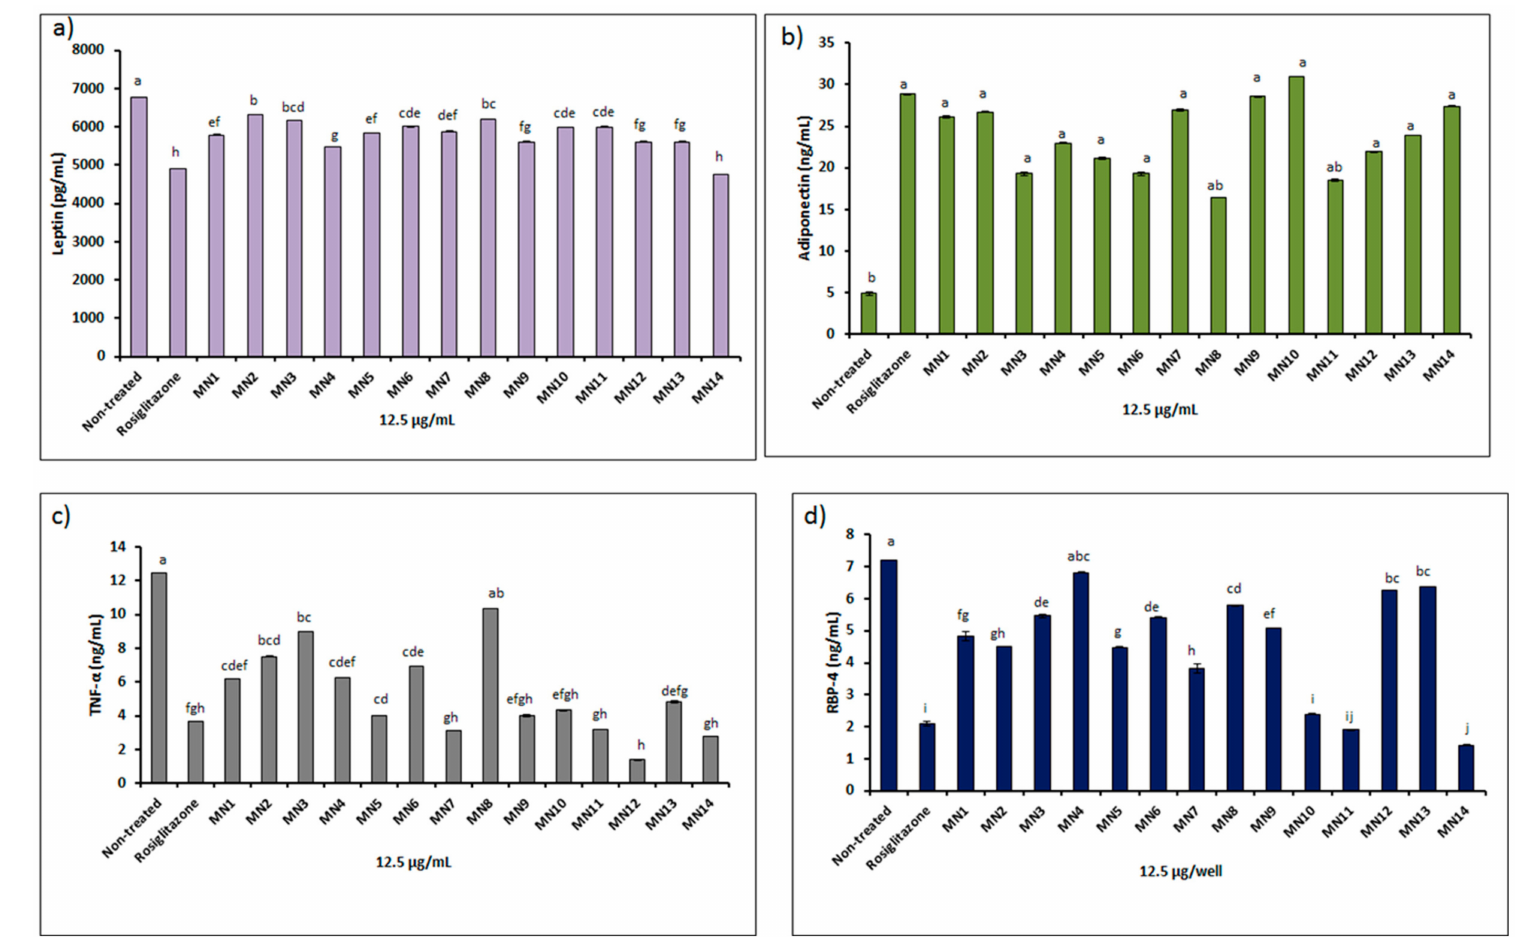
Figure 9. Adipokines measurement of adipocyte after flavonoids treatment at 12.5 µ g/mL; ( a ) leptin, ( b ) adiponectin, ( c ) TNF- α , ( d ) RBP-IV. Mean ± S.D., n = 3, mean values that do not share a letter are significantly different ( p <